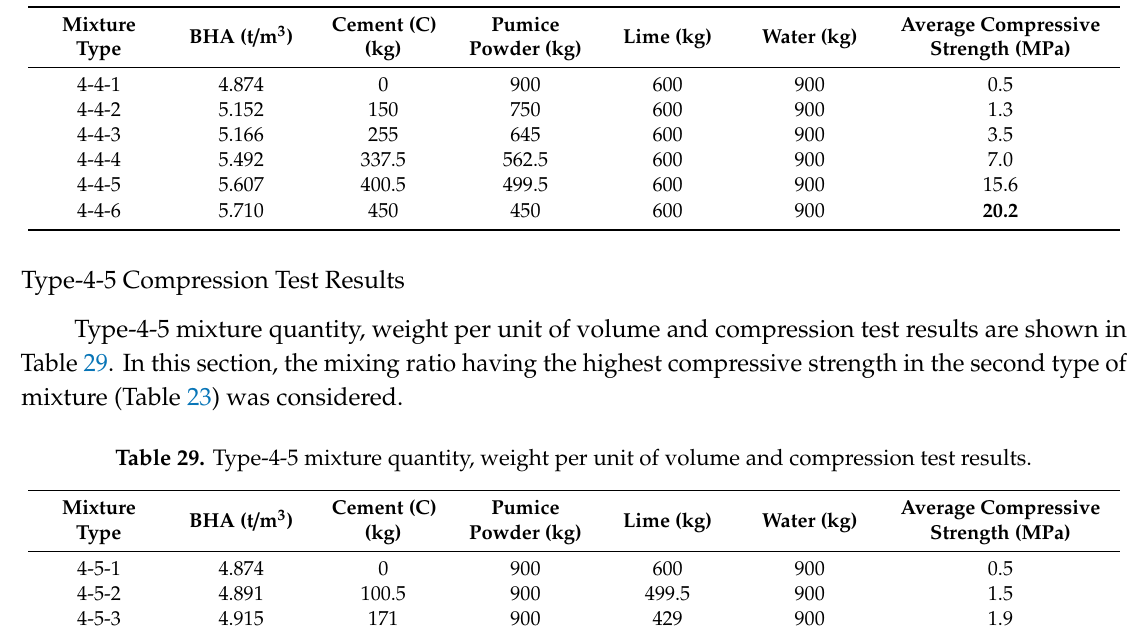
Table 28. Type-4-4 mixture quantity, weight per unit of volume and compression test results.